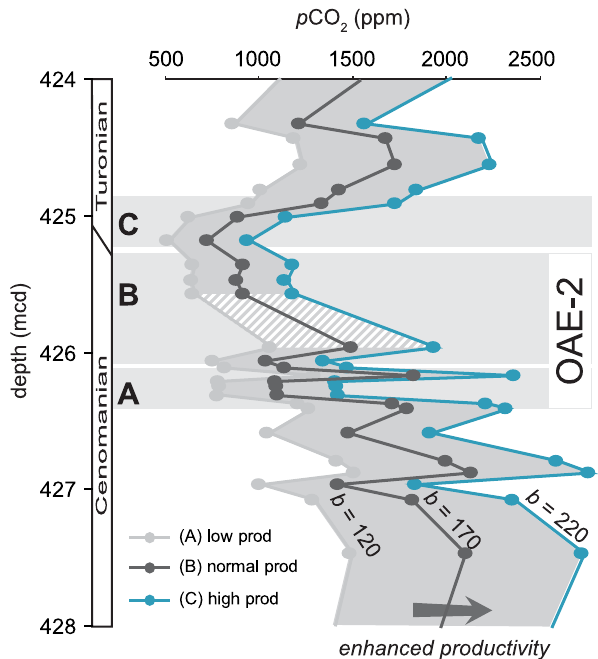
Fig. 7. Plots of p CO 2 levels across the OAE-2 interval at Demerara Rise Site 1260. Calculated with low ( b = 120), normal ( b = 170) and high ( b = 220)